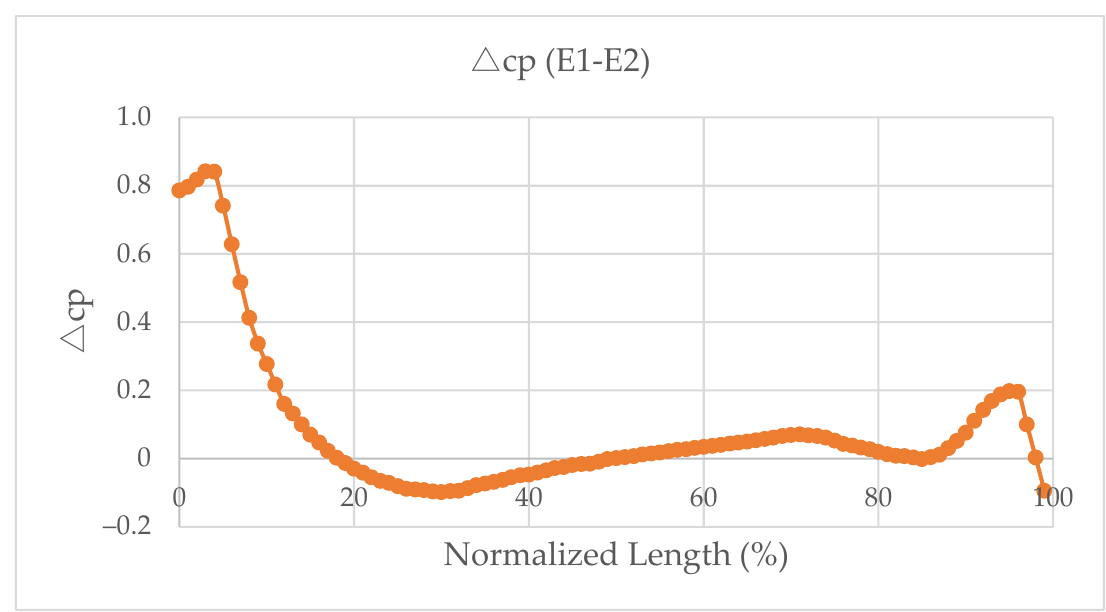
Figure 18. Coefficient of the pressure difference between E1–E2.